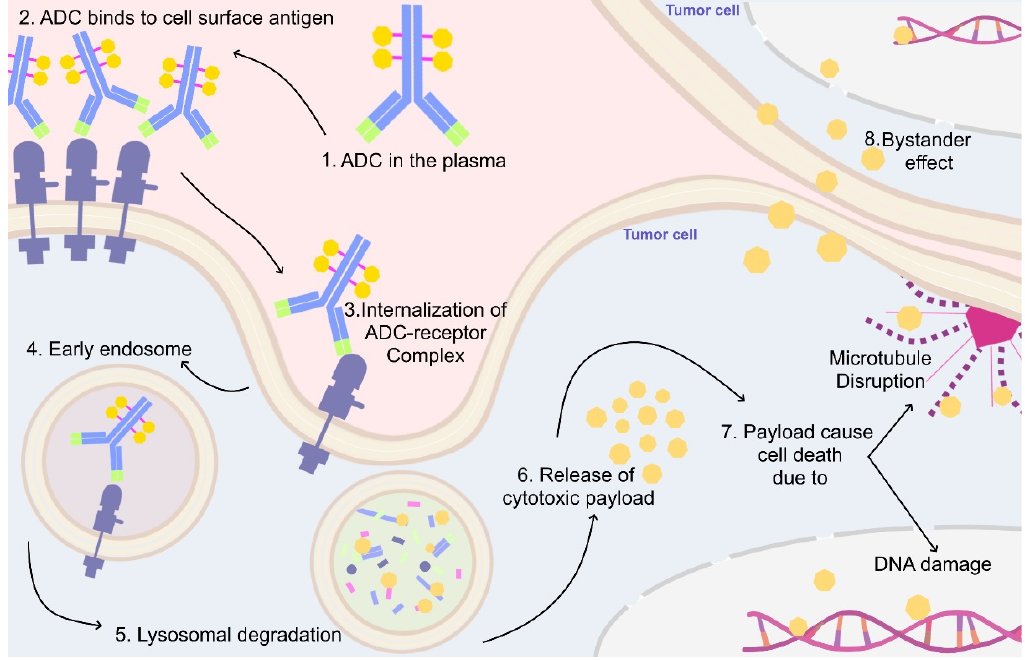
Figure 3. Antibody-drug conjugate mechanism of action. Once the ADC is administered, (1) it is released into the bloodstream. (2) The antibody portion of the ADC binds to overexpressed target tumor antigen/receptor (e.g., HER2). (3) Upon binding, the ADC-receptor complex undergoes receptor-mediated endocytosis, leading to the formation of endosomes (4). Within the lysosome, (5) the ADC-receptor complex is degraded, and the linker is cleaved, leading to the release of cytotoxic payloads (6). Depending on the type of payload used, (7) it will cause cell death either through DNA damage or microtubule disruption. Additionally, (8) payloads that have a membrane-permeable nature will exert the same cytotoxic effect on neighboring cells through a process known as the bystander effect, regardless of their antigen expression.